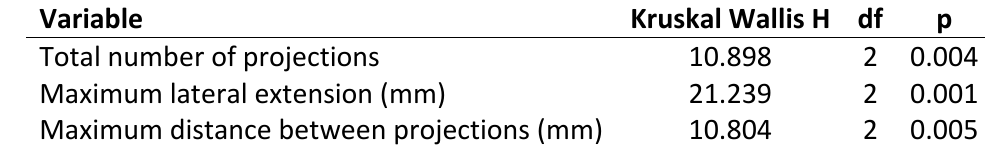
Table 6. Kruskal Wallis test of projection types and morphological measures.